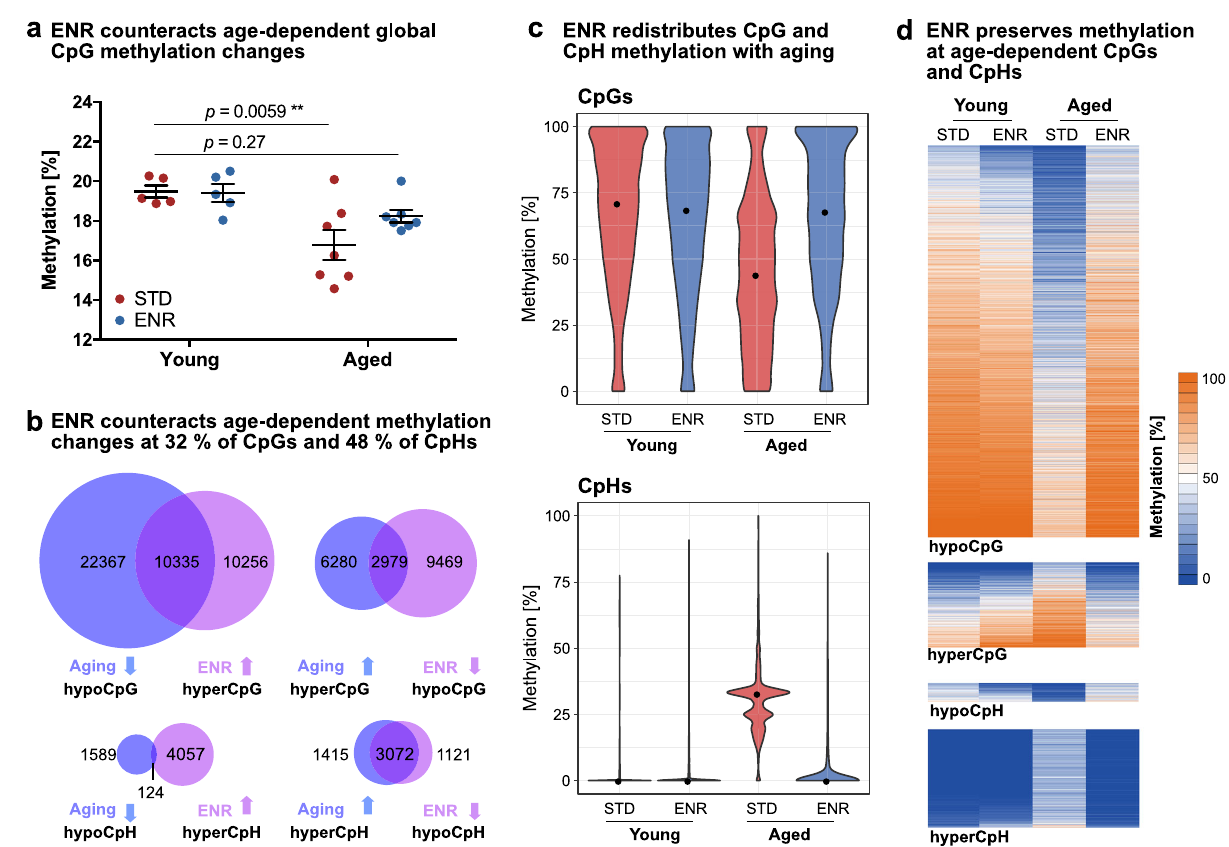
Fig. 2 Environmental enrichment protects the dentate gyrus from age-related CpG and CpH methylation changes. DNA methylation pro fi les of young mice housed in ENR or STD for four days (Young ENR; Young STD; n = 5) and aged mice housed in ENR or STD for one year (aged ENR; Aged STD; n = 7) as determined by RRBS. a Aging decreases global CpG methylation in STD but not in ENR mice ( p -values from two-way ANOVA with Dunnett ’ s post hoc test; depicted are means ± SEM). b Aging and ENR induce opposite DNA methylation changes. Overlap of aging-induced hypoCpG with ENR-induced hyperCpG in aged mice (top left) and aging-induced hyperCpGs with ENR-induced hypoCpGs (top right). Overlap of aging- and ENR-induced CpH methylation changes (bottom). Signi fi cant overlaps with p < 1 × 10 − 100 for all comparisons as determined by one-sided hypergeometric tests. c Age- and ENR-dependent changes of the distributions of methylation percentages of the 13,314 CpGs and 3,196 CpHs counteracted by ENR. Medians of methylation percentages per group are highlighted as black dots (CpGs; Young STD: 71.05%, Young ENR: 68.57%, Aged STD: 44.03%, Aged ENR: 67.93%. CpHs; Young-STD: 0%, Young-ENR: 0%, Aged-STD: 32.85%, Aged ENR: 0%). d Heatmaps depicting the absolute methylation percentages in the individual groups at individual CpGs and CpHs. While aged STD mice show distinct methylation at individual sites, aged ENR mice show methylation levels similar to young